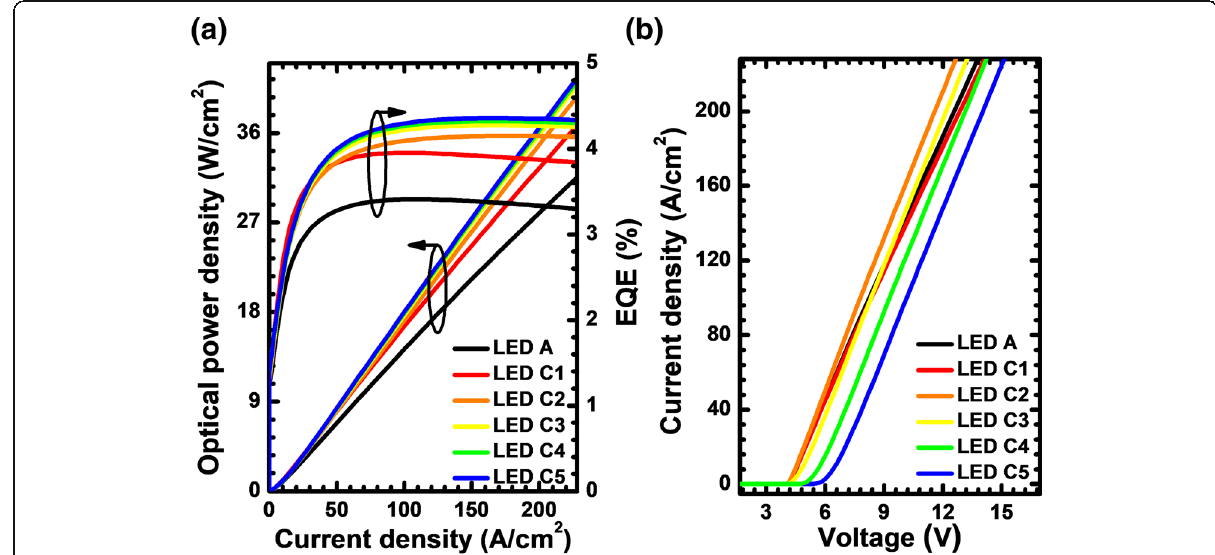
Fig. 16 a Optical output power density and EQE as a function of the injection current and b current-voltage characteristics for LEDs A, C1, C2, C3, C4, and